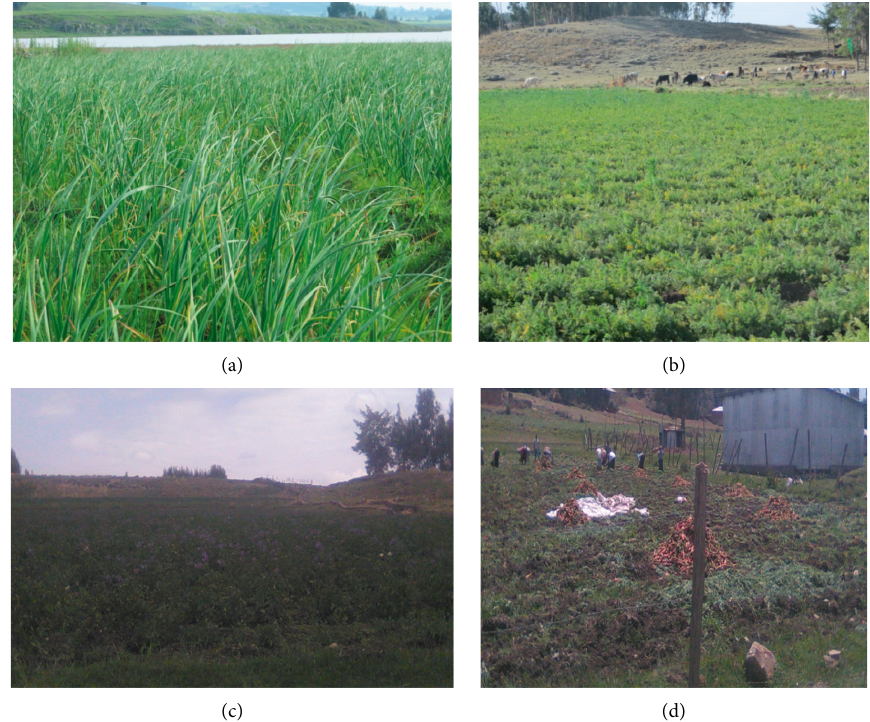
Figure 5: Photos showed garlic (a) and carrots (b, d) in the growing/flowering stage and carrot (c, e) in the harvesting stage in the irrigated lands of Washa (a, b) and Borale sites (c, d) (Photo taken in June